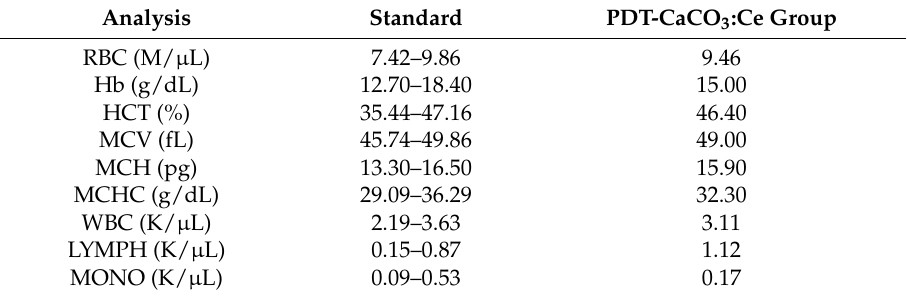
Table 1. Bio-chemical analysis of blood samples from PDT-CaCO 3 :Ce group. Table 2. Bio-chemical analysis of the blood/serum samples from PDT-CaCO 3 :Ce